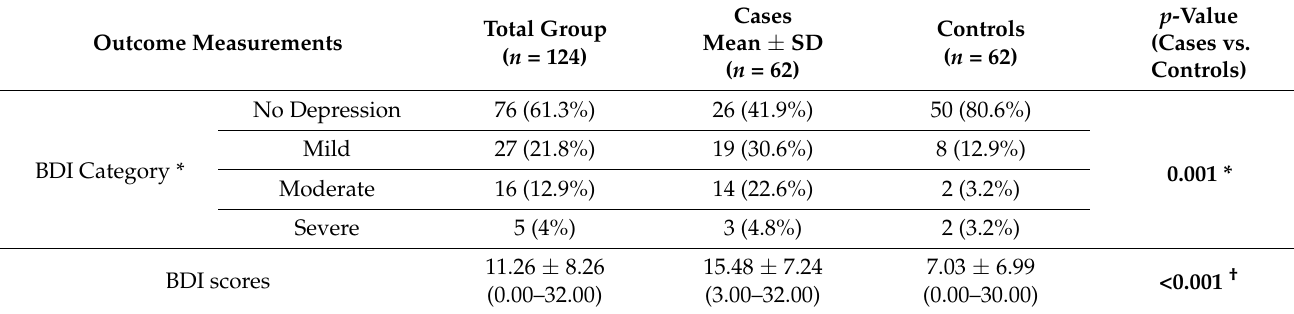
Table 2. Comparisons of BDI scores and categories between the Parkinson’s patients and healthy matched-paired controls.